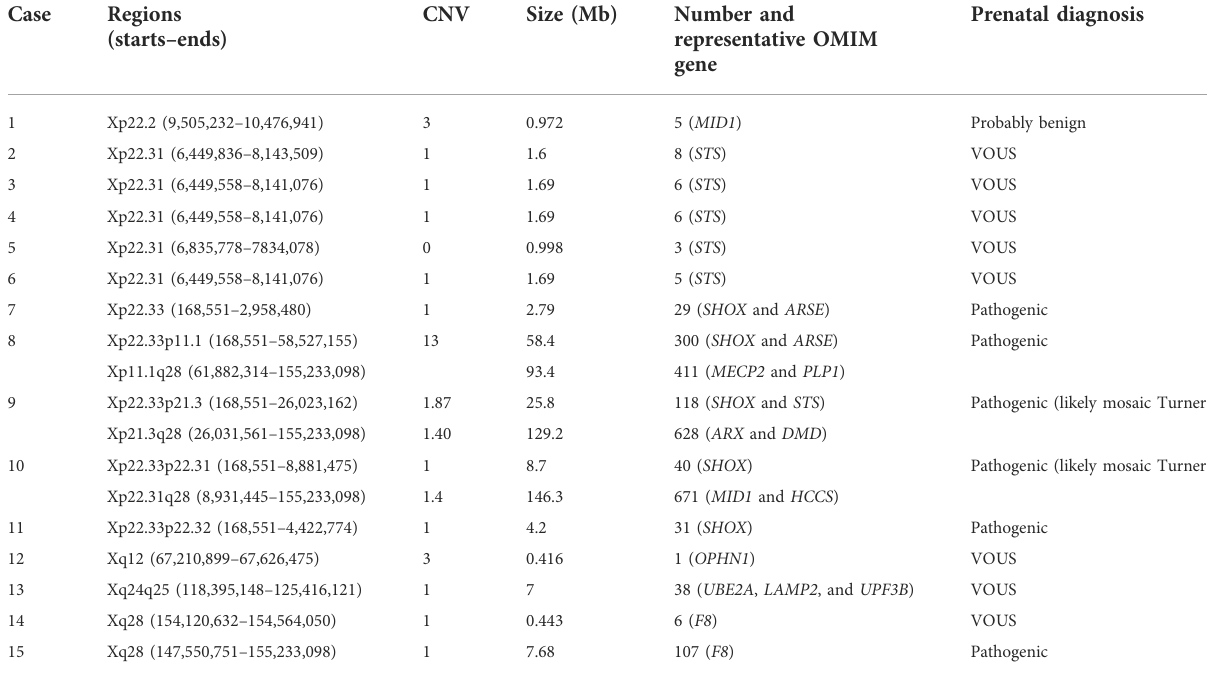
TABLE 3 X chromosomal deletions/duplications in female fetuses.